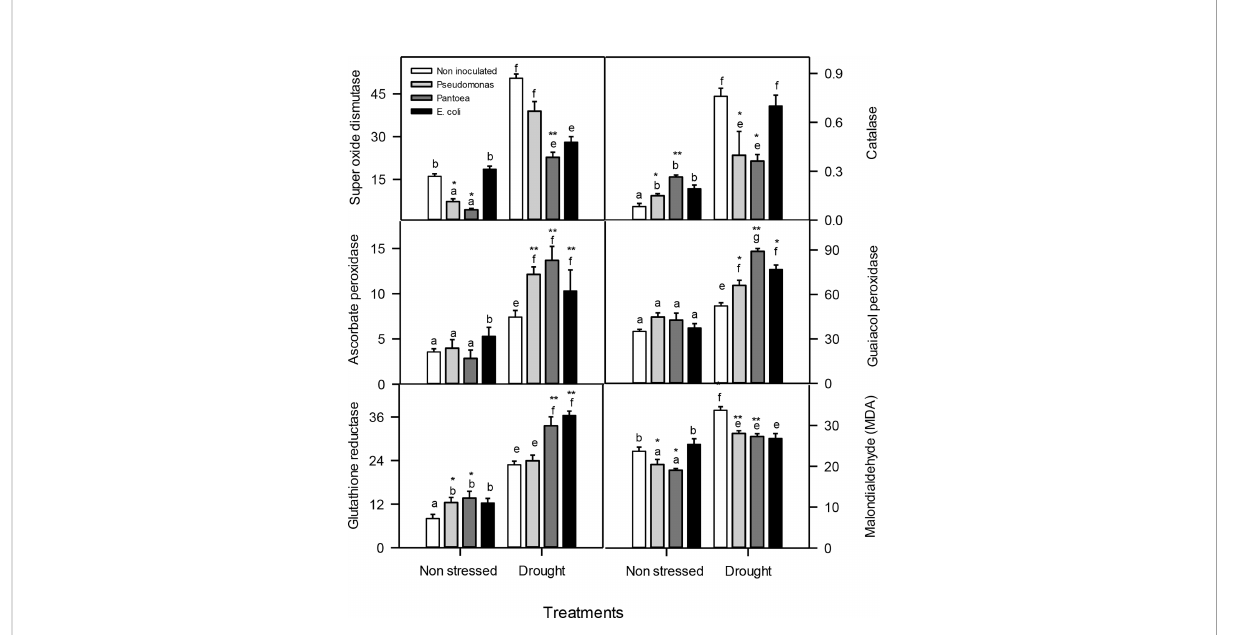
FIGURE 4 Antioxidant enzyme levels ( m mol mg-1 prot min-1) FW — superoxide dismutase (SOD), catalase (CAT), ascorbate peroxidase (APX), guaiacol peroxidase (GPOX), glutathione reductase (GR), and malondealdehyde (MDA ( m mol g-1 FW)) — in drought-stressed and non-stressed (well- watered) Hordeum vulgare inoculated with three bacterial strains ( Pseudomonas sp . (ITS Group 11), Pantoea sp. (ITS Group 2), or E. coli ). F and P (** P< 0.01, *P< 0.05) values of the two-way ANOVAs are presented, drought, bacteria and drought x.The lower case letters shows the signi fi cant differences among means (P< 0.05) assessed by Fisher ’ s protected least signi fi cance difference